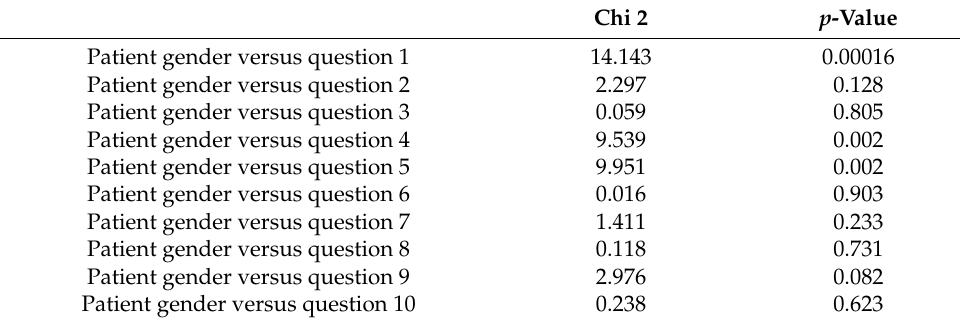
Table 3. The results of Questionnaire I according to the gender of the